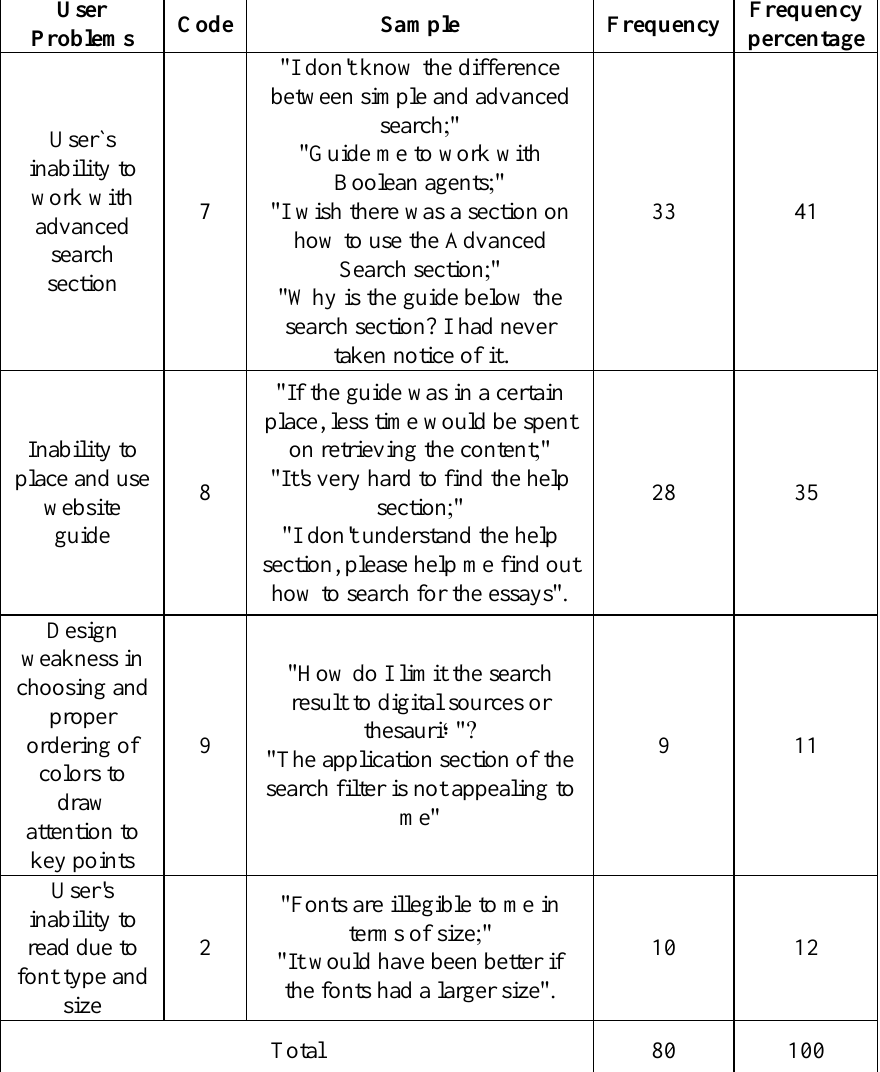
Table 7 - Codes for Visual Elements of the Search